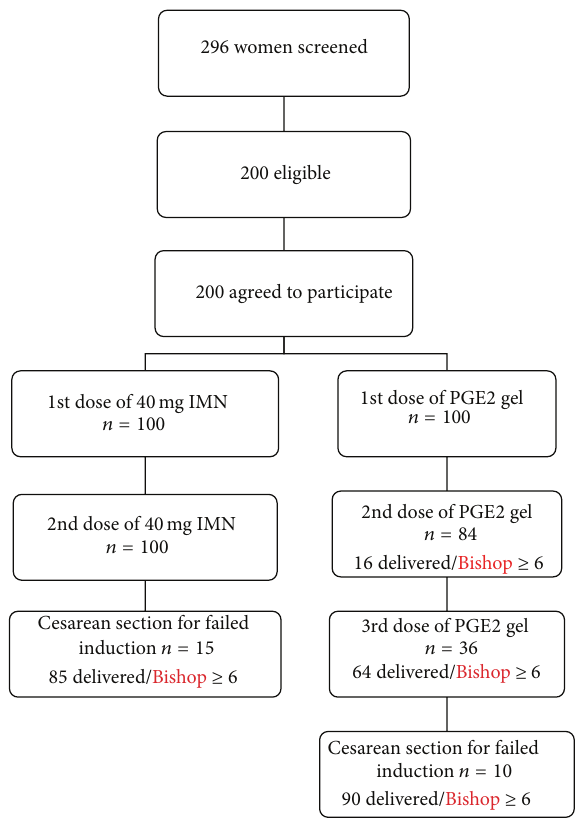
Figure 1: Flowchart of study participants.